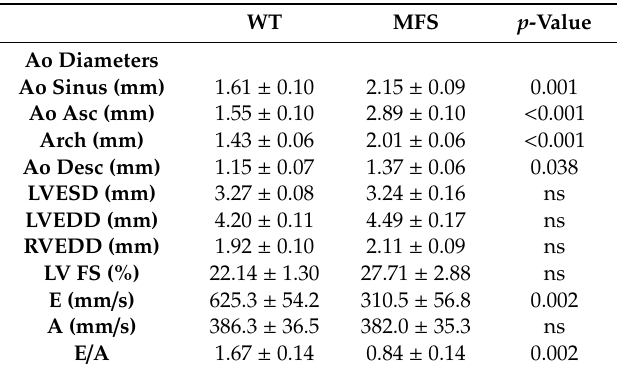
Table 1. Physiological parameters of the aorta and cardiac ventricles of wild-type (WT) and Marfan syndrome (MFS) mice obtained by ultrasound measurements at 3 months of age. Measurements of the aorta include 12 WT and 12 MFS mice. Measurements of the cardiac ventricles include 5 WT and 6 MFS mice. p -values were calculated using an independent samples test. WT MFS p